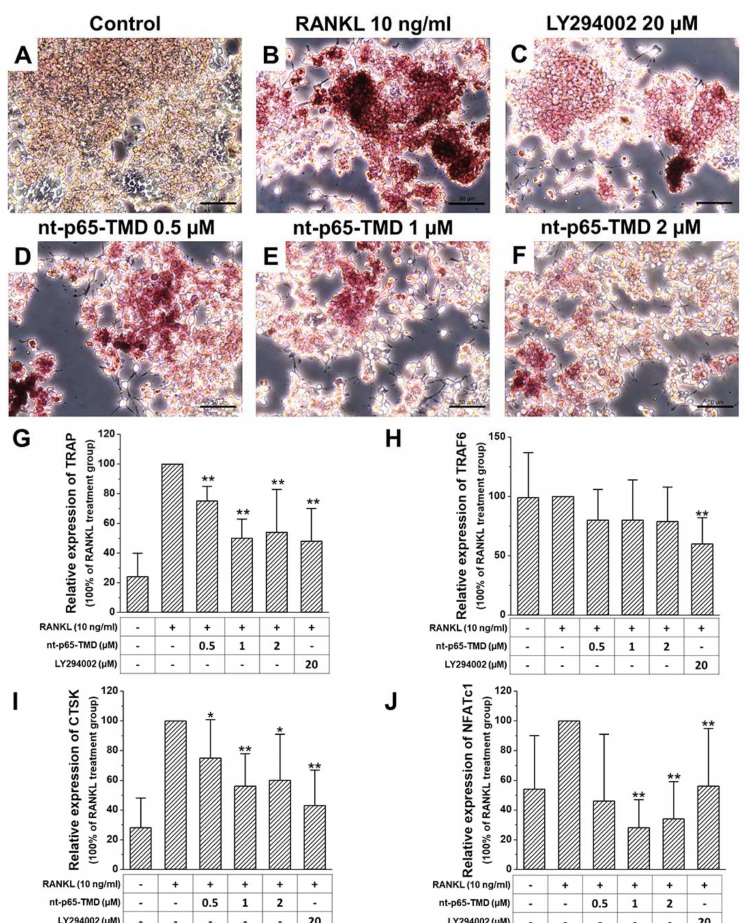
Figure 2. Osteoclast differentiation of nt-p65-TMD in RAW264.7 cells ( A – F ) tartrate-resistant acid phosphatase (TRAP) staining of nt-p65-TMD in RAW264.7 cells. Cells were pretreated with different concentrations of nt-p65-TMD for 2 h followed by treatment with 10 ng/mL receptor activator of nuclear factor-kB ligand (RANKL) for 3 days. Subsequently, RAW264.7 cells were fixed and stained to detect TRAP. The osteoclasts were stained red. Scale bars = 50 µ m ( G – J ) Changes in the expression of the osteoclast-related genes of nt-p65-TMD in RAW264.7 cells. Cells were pretreated with different concentrations of nt-p65-TMD for 2 h followed by treatment with 10 ng/mL RANKL for 3 days. RNA was isolated from RAW264.7 cells and cDNA was synthesized. Expression of tartrate-resistant acid phosphatase (TRAP), TNF receptor associated factor 6 (TRAF6), CathepsinK (CTCK), and nuclear factor of activated T cell, cytoplasmic 1 (NFATc1) was evaluated using quantitative RT-PCR relative to RANKL treatment group (normalized to 100%). Data were obtained from five separate experiments, with all samples run in duplicate. The data are expressed as mean ± standard deviation values. The expression of the genes differed significantly; t-test and Mann–Whitney U test, * p < 0.05, ** p <